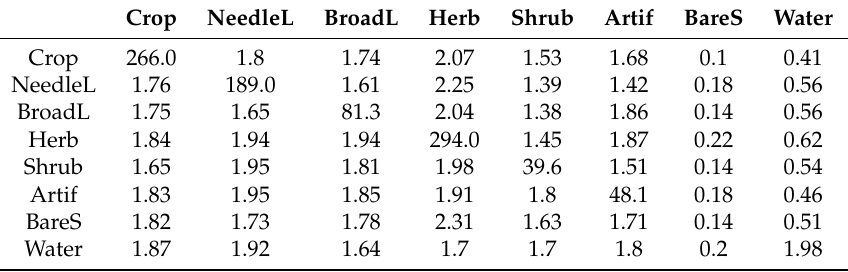
Table A5. Confusion matrix with nearly constant errors and large overall accuracy. Crop